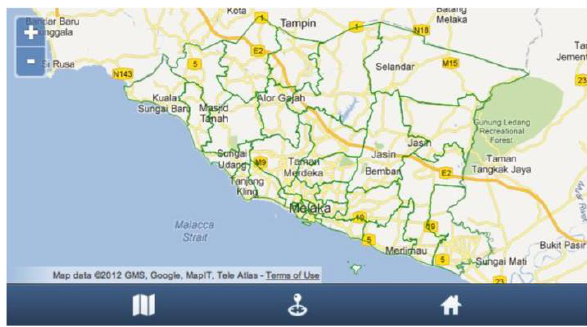
Figure 1. The Projection of Data Source is Spherical Mercator To get a clear view of this problem, the discussion starts by displaying a map that has overlay layers. These overlay layers consist of same geographic features with different